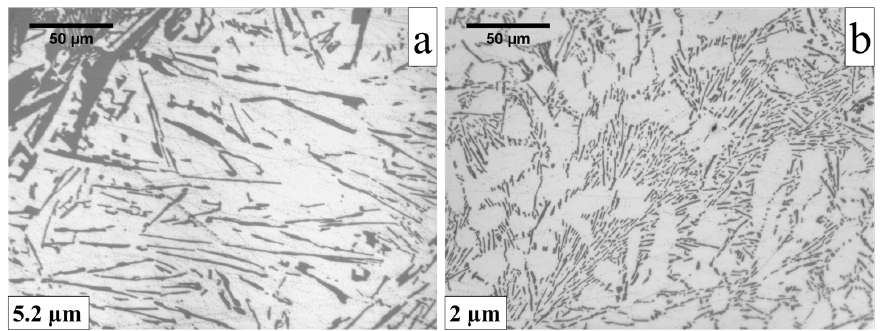
Figure 5. Different eutectic-structure morphologies in the stirred parts. ( a ) Coarse eutectic structure grown near primary Si phase ( λ = 5.2 µ m). ( b ) Fine eutectic structure grown near primary Al phase ( λ = 2.0 µ